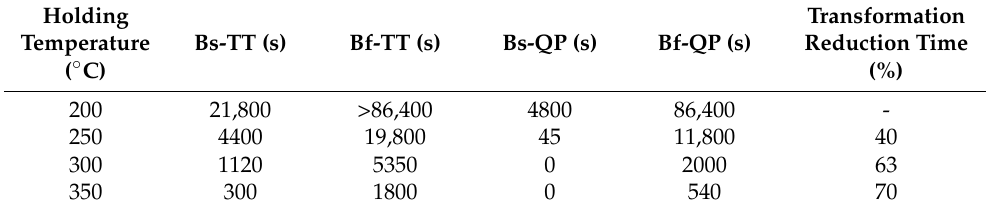
Table 1. Bainitic transformation start and finishing times for different heat treatments.